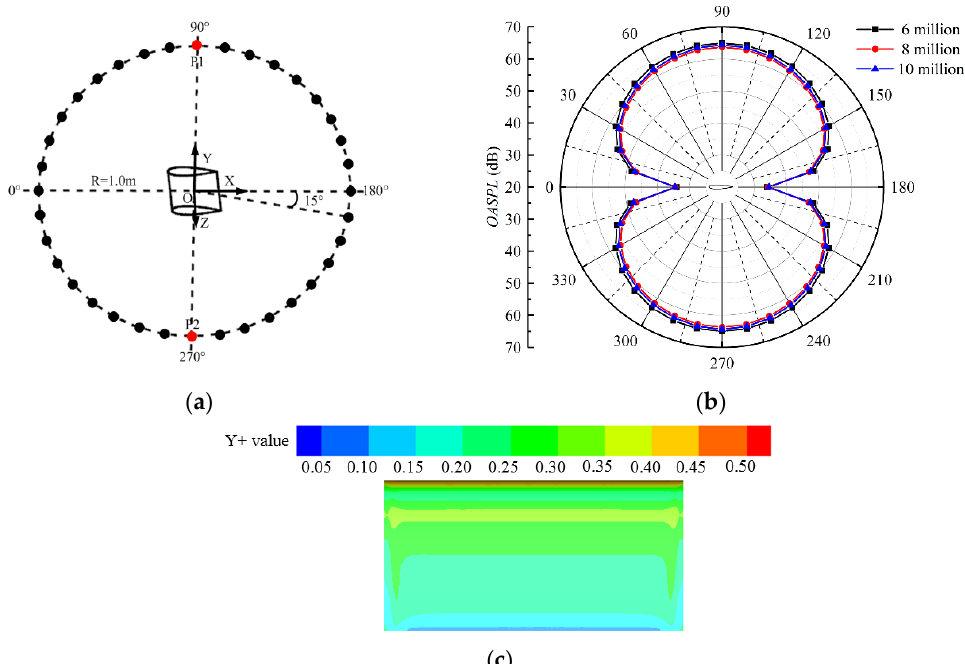
Figure 4. Mesh determination. ( a ) Monitoring points; ( b ) Mesh independence; ( c ) Y + value of the blade surface.